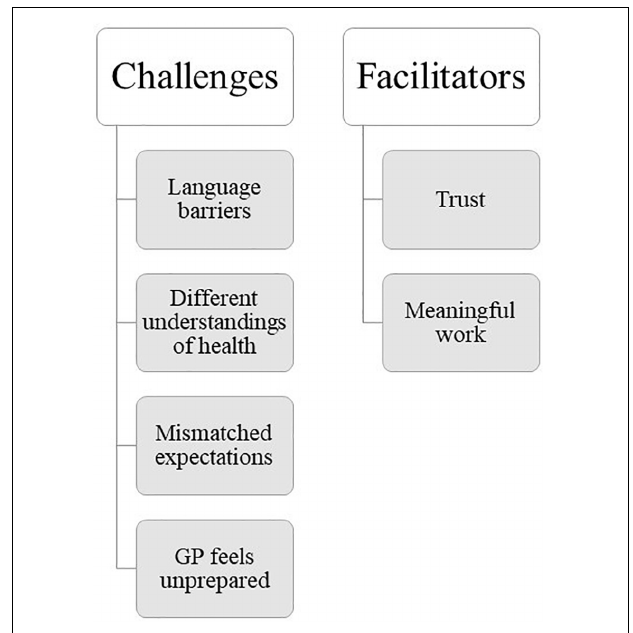
FIGURE 2 | Organisation of